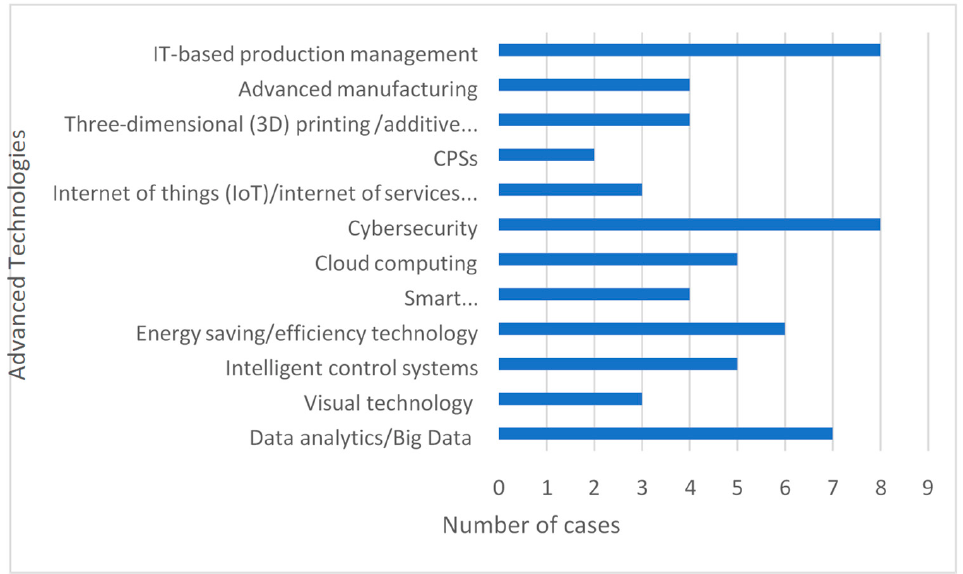
Figure 3. Advanced Technologies used by the case studies.